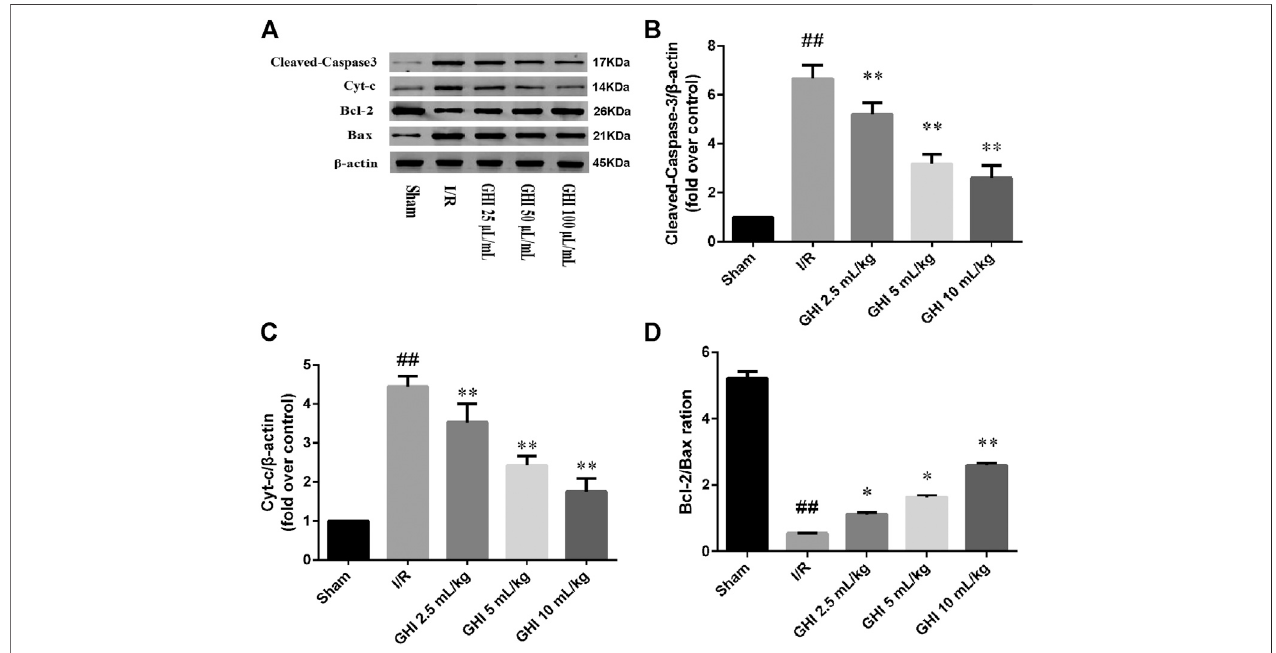
FIGURE 3 | Western blot analysis of cleaved caspase-3, Bcl-2, Bax, and Cyt-c in the cerebral I/R region. Groups were as follows: Sham group (Sham), ischemia- reperfusiongroup(I/Rgroup), GHI 2.5 ml/kggroup, GHI5 ml/kg group,and GHI10 ml/kg group. ## p < 0.01vs. theSham group,* p < 0.05,** p < 0.01vs.theI/Rgroup.